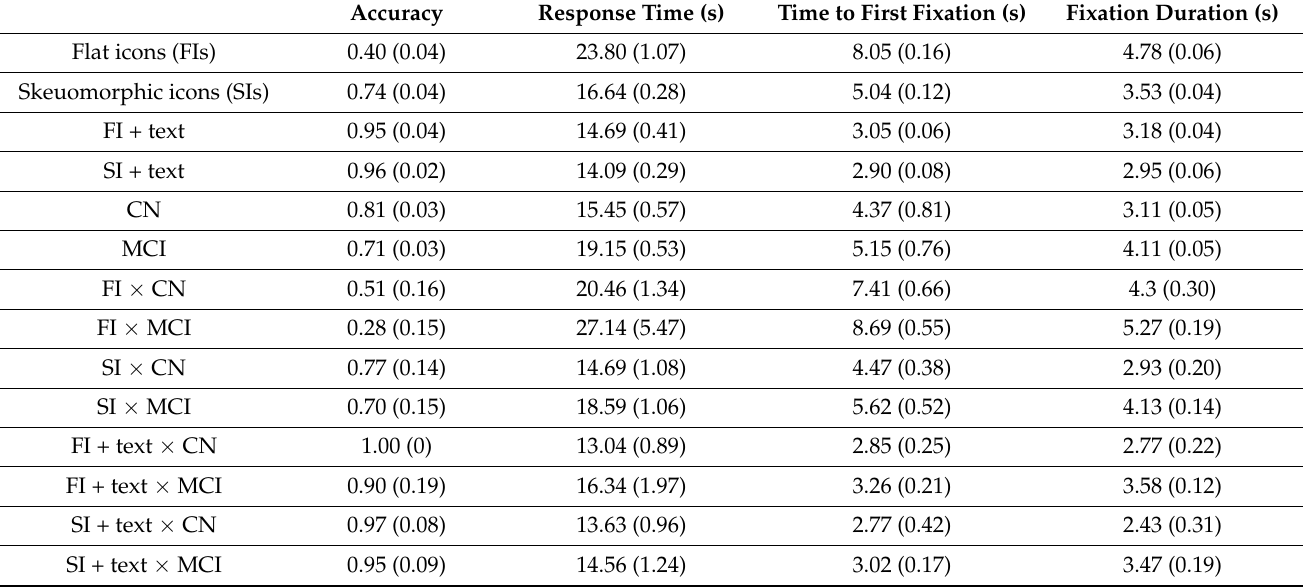
Table 3. Mean (standard deviation) of visual search accuracy, response time, time to first fixation (TFF), and fixation duration (FD) for different icon types and cognitive